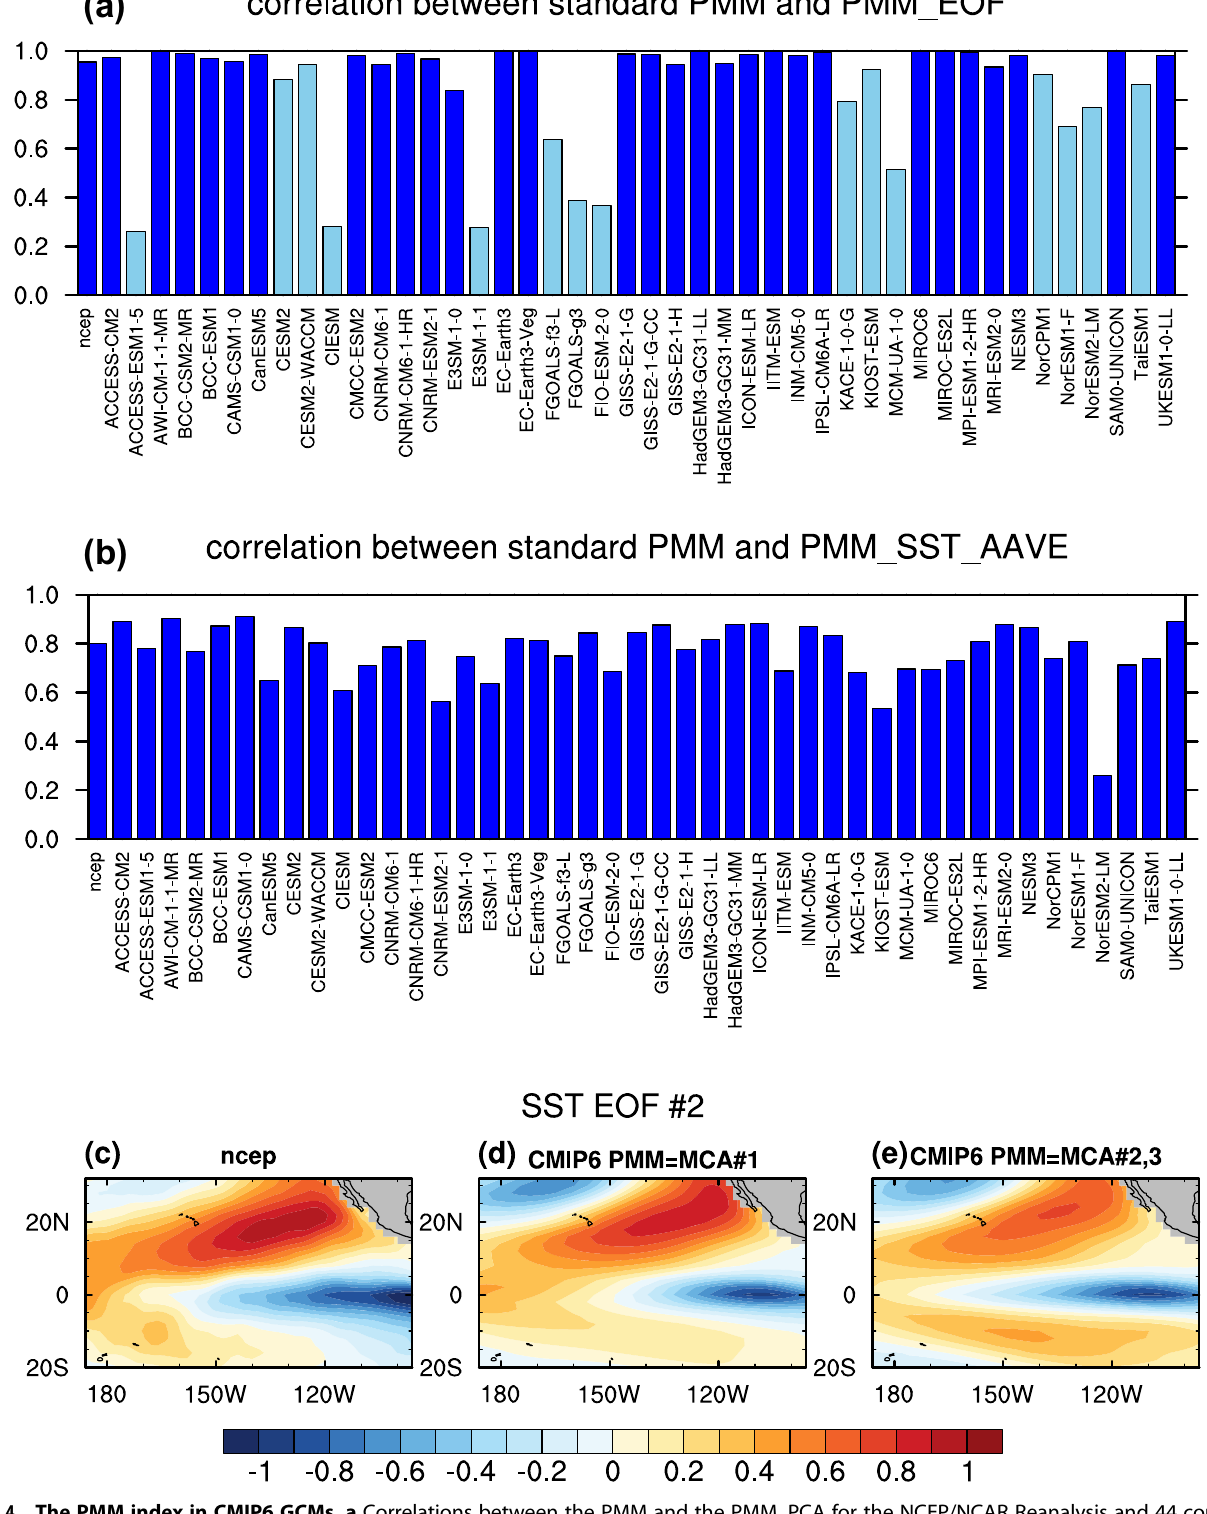
Fig. 4 The PMM index in CMIP6 GCMs. a Correlations between the PMM and the PMM_PCA for the NCEP/NCAR Reanalysis and 44 coupled general circulation model (GCM)s from the CMIP6 intercomparison. For the models, the PMM is taken as the MCA mode that has the highest pattern correlation with the PMM mode of the NCEP/NCAR reanalysis. The models for which this is not the fi rst MCA mode are shaded in light blue. b As in ( a ), but for the correlation of the PMM with SST averaged over the area shown in Fig. 1c. c Second EOF of the PCA of SST for the NCEP/NCAR reanalysis. d As in ( c ) but averaged over the CMIP models for which the PMM is the fi rst MCA mode. e As in ( c ) but averaged over the CMIP models for which the PMM is not the fi rst MCA mode (light blue shading in ( a )). All correlations shown in ( a ) and ( b ) are signi fi cant at the 95% con fi dence